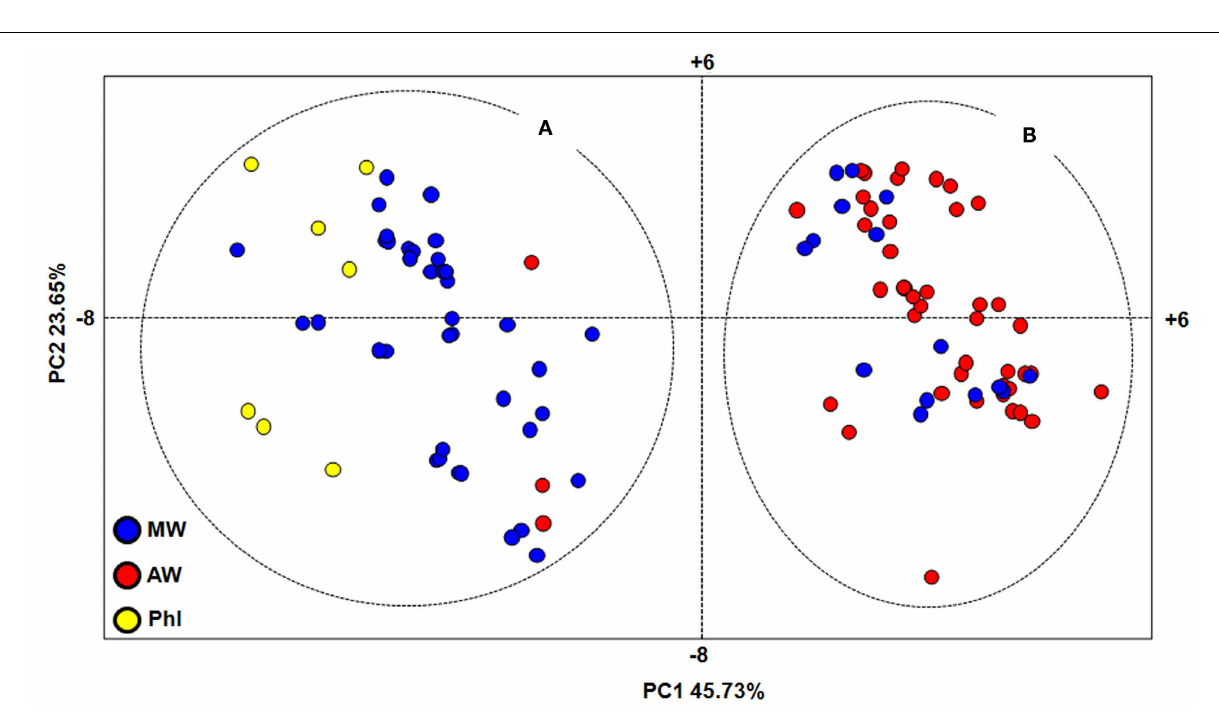
FIGURE 3 | Genetic relationships within the P. vulgaris accessions, as assessed by principal component analysis. MW, Mesoamerican wild; AW, Andean wild; PhI, northern Peru and Ecuador; (A,B) , major groups identified by PCA analysis.